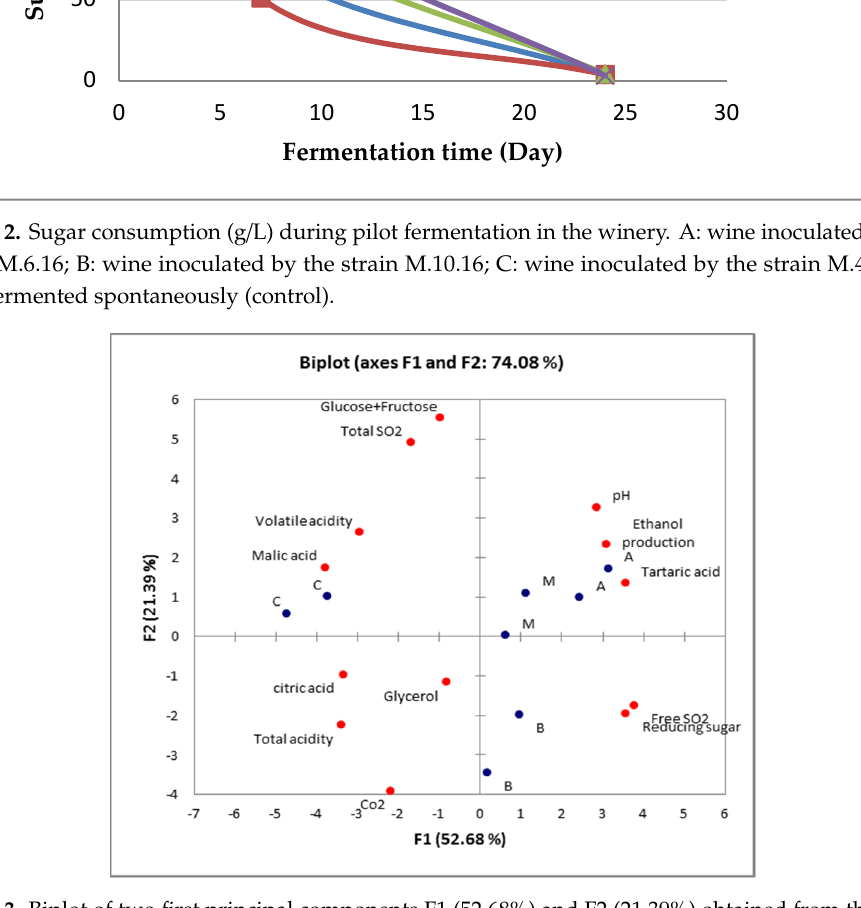
Figure 3. Biplot of two first principal components F1 (52.68%) and F2 (21.39%) obtained from the main technological parameters of three inoculated wines (A, B, and C) and one spontaneous wine (M). The bleu points represent the position of the tested wines in duplicates, with respect to the 13 technological parameters indicated in red